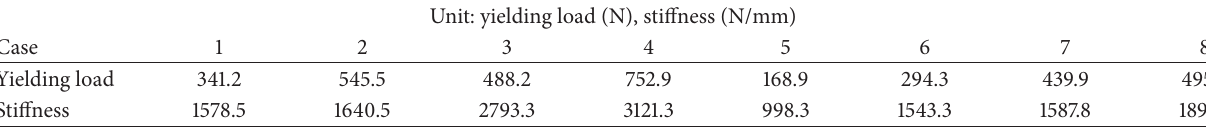
Table 2: Average yielding load and stiffness of NGH pellets.